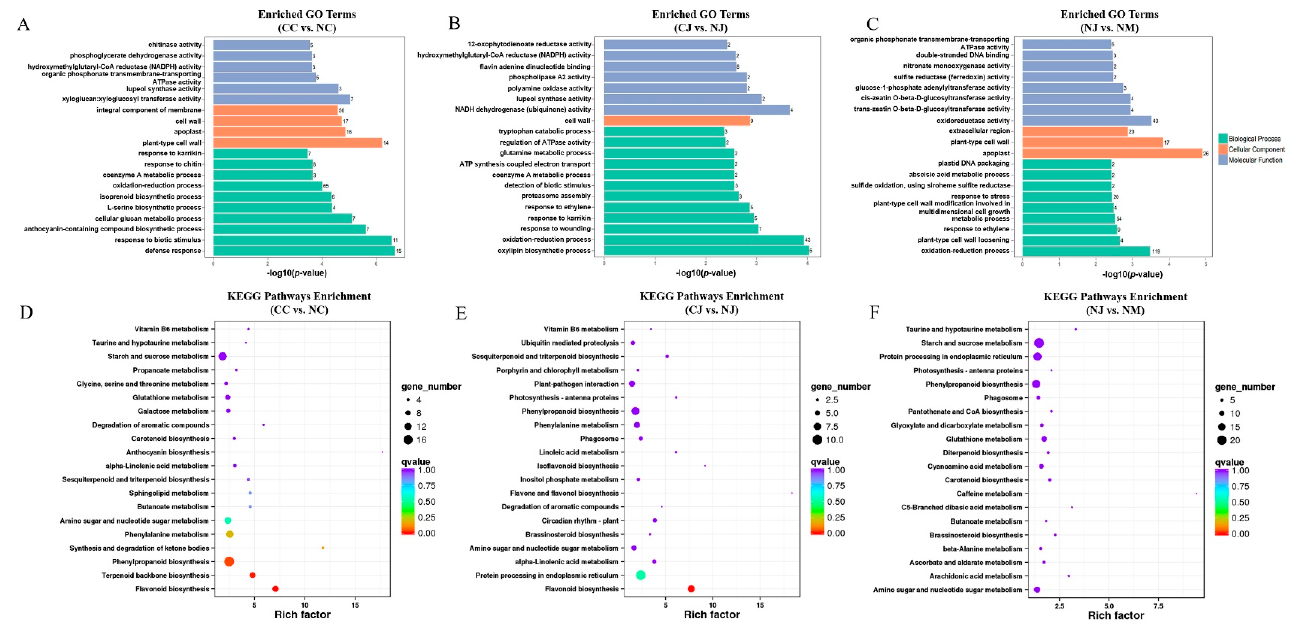
Figure 3. The enrichment analysis of the DEGs using GO and KEGG pathways. ( A – C ) GO classifi- cations of DEGs in CC vs. NC, CJ vs. NJ, and NJ vs. NM, respectively. The x-axis indicates − log10 ( p -value), number of DEGs, and the y-axis indicates the top 20 enriched GO terms. The numbers on the bar graph show the number of genes enriched in each term. ( D – F ) The top 20 enriched KEGG pathways of the DEGs in CC vs. NC, CJ vs. NJ, and NJ vs. NM, respectively. The rich factor is the ratio of DEGs and the total number of detected genes in the pathway. The bubble size represents the number of DEGs detected in each KEGG pathway. The color of the bubble represents the q